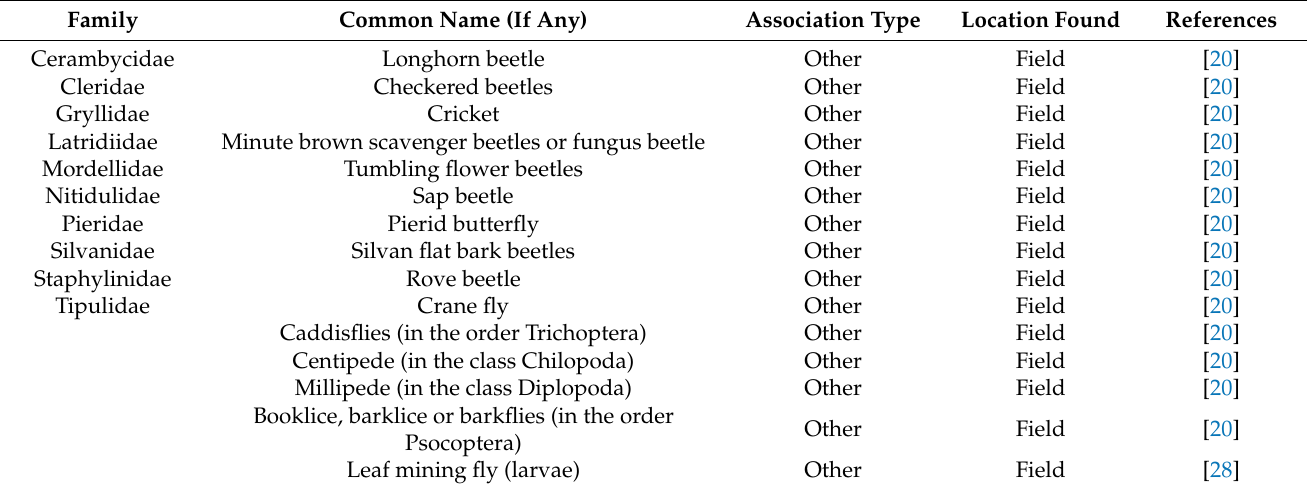
Table 3. A list of some arthropods considered neither pest nor beneficial reported on hemp in the United